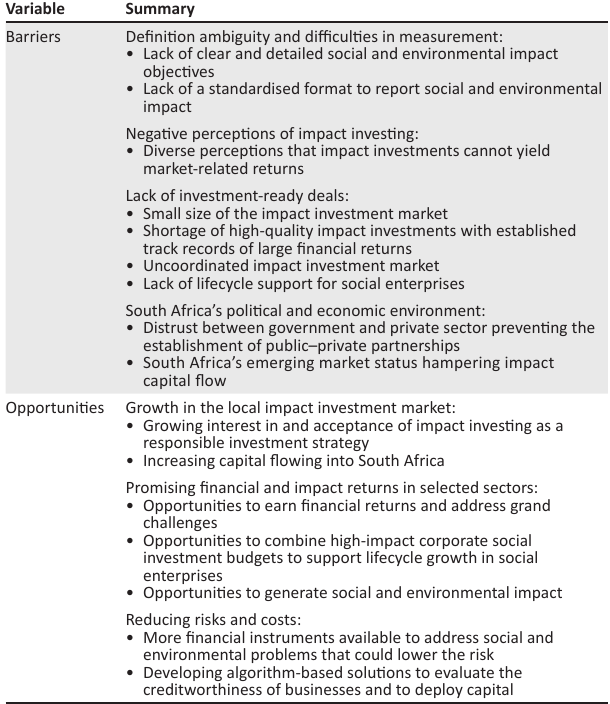
TABLE 1: Summary of barriers and opportunities faced by local impact investors.